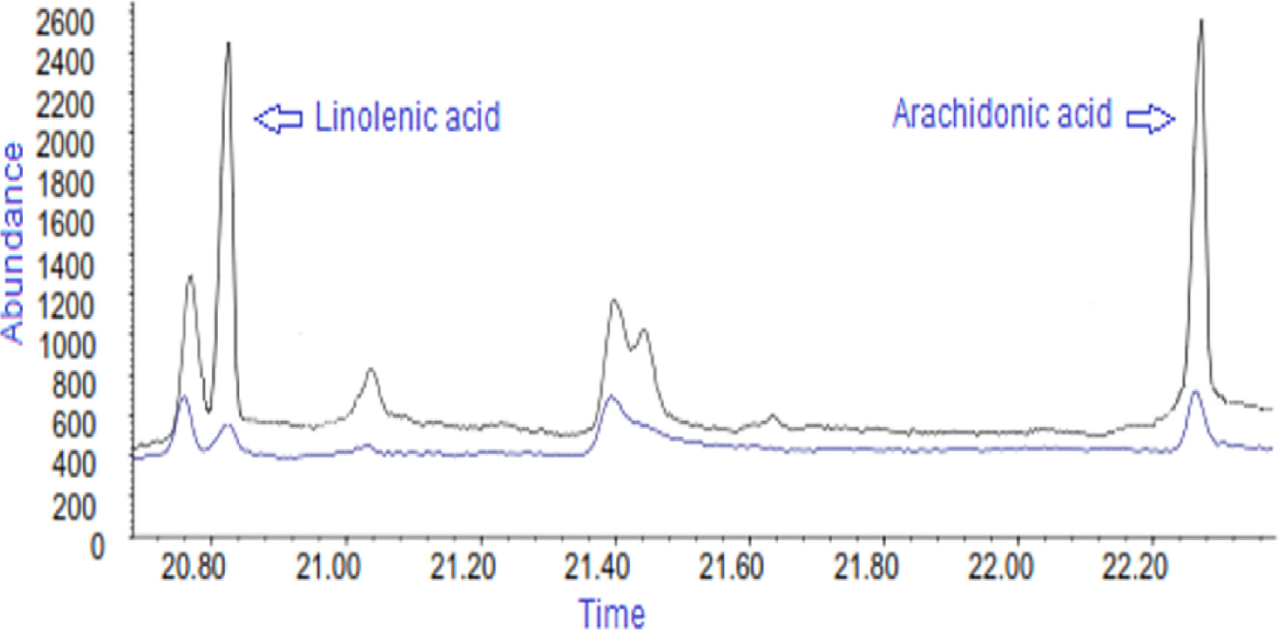
Fig 7. Representative GC-EIMS (SIM) chromatogram of a serums sample. Serum sample spiked with 4 μ M of linolenic acid and arachidonic acid (black line)and serum samples analyzed without spiking fatty acids(blue line).